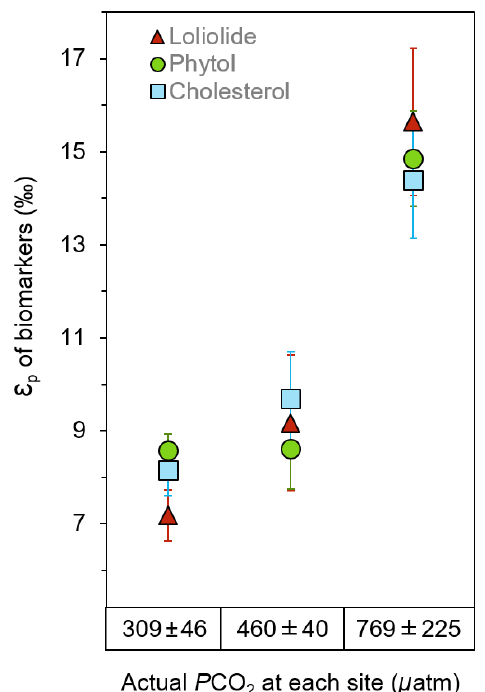
Figure 4. The ε p of general algal biomarkers in sediments. Loliolide (triangle), phytol (circle), and cholesterol (square) from the control, mid- p CO 2 and high- p CO 2 sites during June sediment collection.